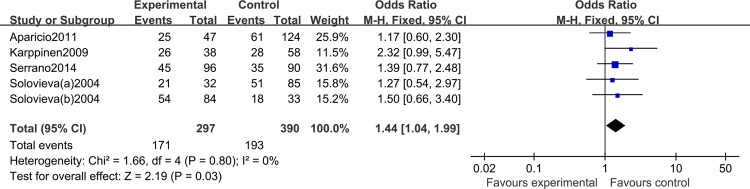
Forest plot of allelic comparison of the IL-1α (+889C/T) polymorphism for overall comparison (CT versus CC).